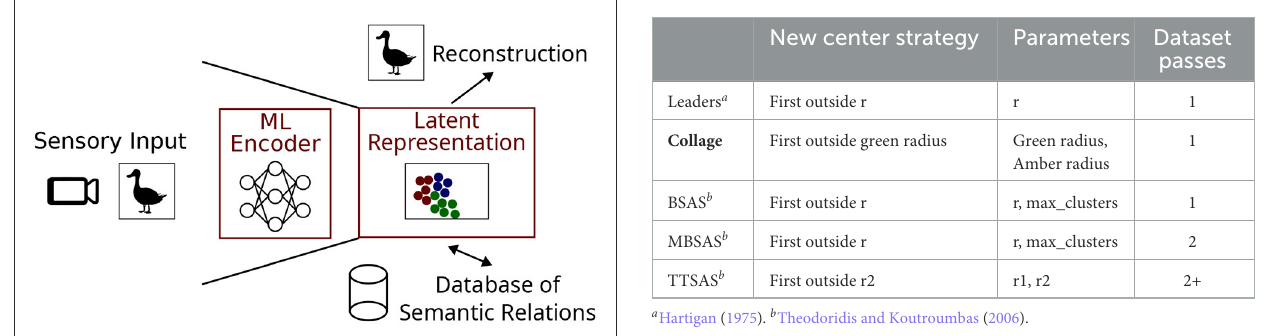
FIGURE1 A sensory pipeline based on image input useful for cognitive artificial intelligence. The machine learning ( ML ) encoder and latent representation are the focus of this work.